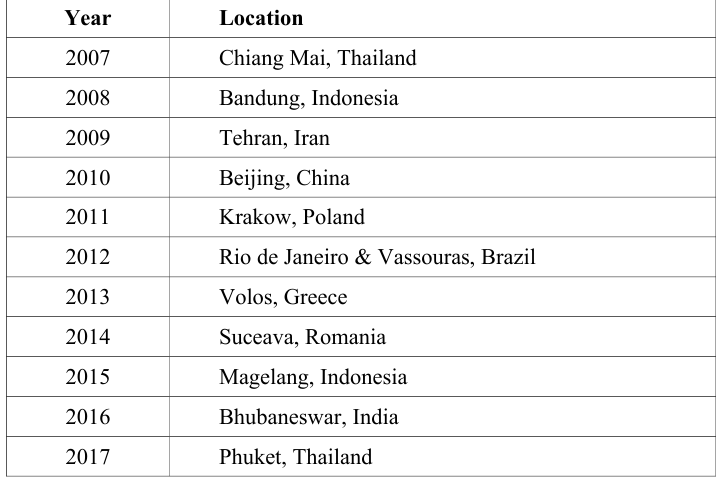
Table 1. Previous International Olympiads on Astronomy and Astrophysics events Year